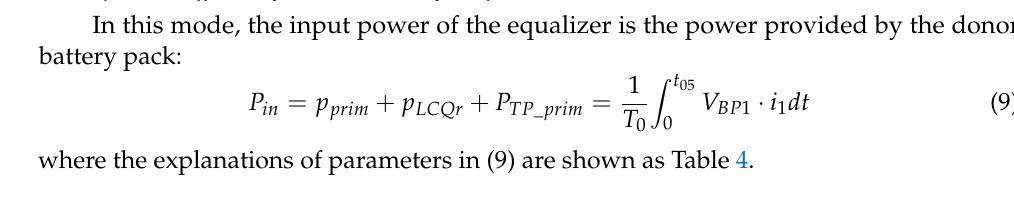
Table 4. Parameters and related explanations in the efficiency and loss